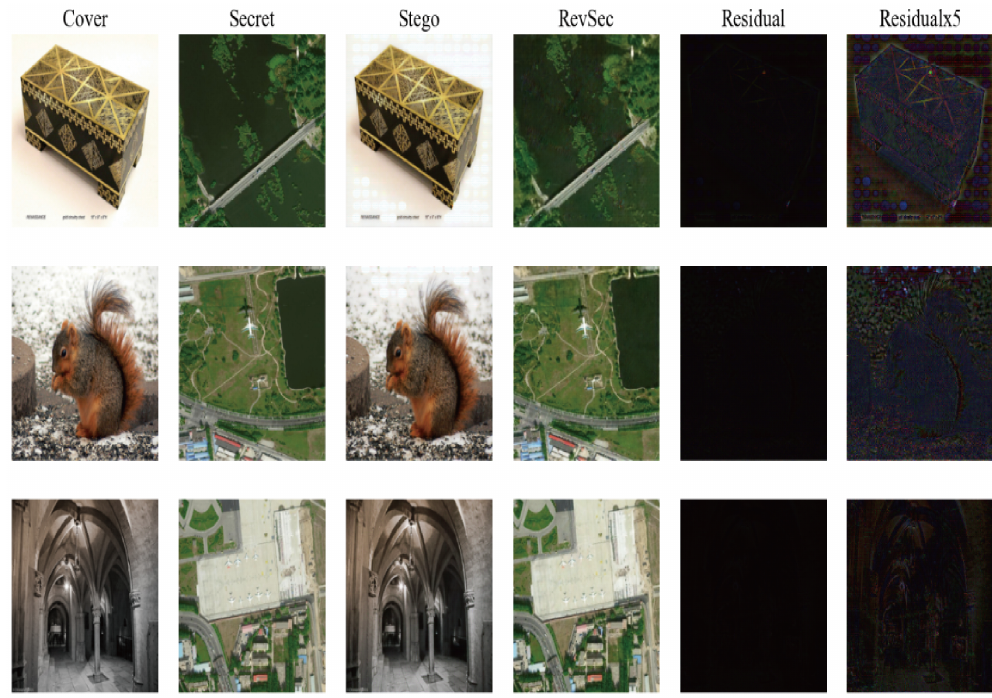
Figure 11. The test results of our proposed scheme on aerial images.